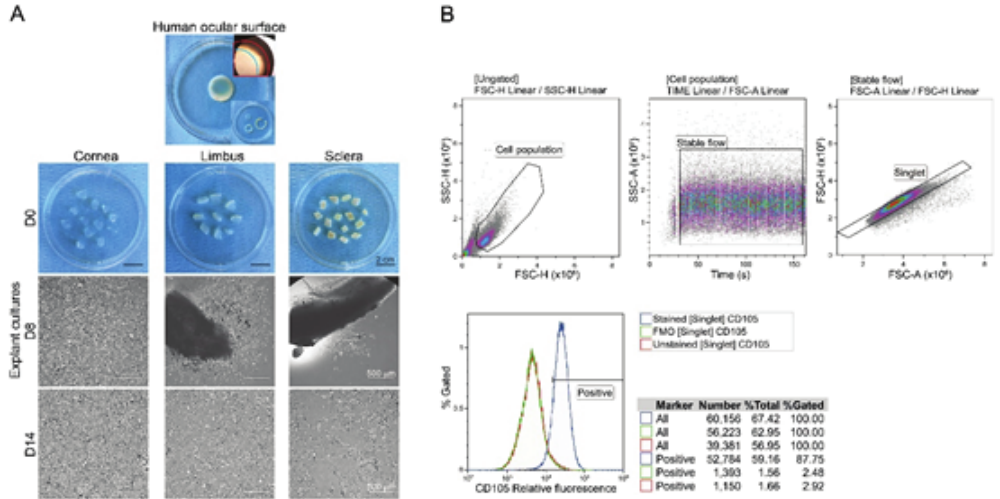
Figure 1. Isolation of human ocular surface stromal cells and outline of gating strategy to determine single maker positive boundary. (A) Donor corneal button with indicated (upper corner inset) and dissected (lower corner inset) corneal, limbal, and scleral compartments. The blue line demarcates cornea and limbus and the red line limbus and sclera ( × 20 original magnification). The representative images from explant cultures at days 0, 8, and 14 are shown. (B) Steps to identify positive populations in the flow cytometric analysis are demonstrated in the example of the